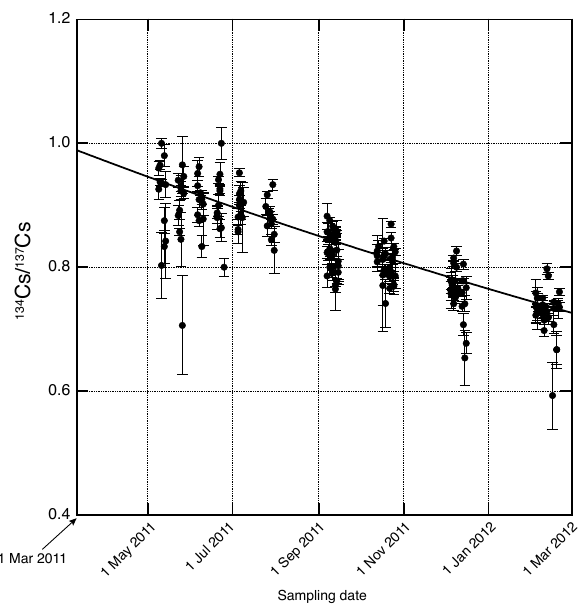
Fig. 6. Temporal variation of 134 Cs/ 137 Cs ratio in the sediments. The line represents the result of a weighted least-squares fit and cor- responds to the following equation: 134 Cs/ 137 Cs= c 1 exp ( − c 2 t) , where c 1 = 0 . 989 and c 2 = 0 .